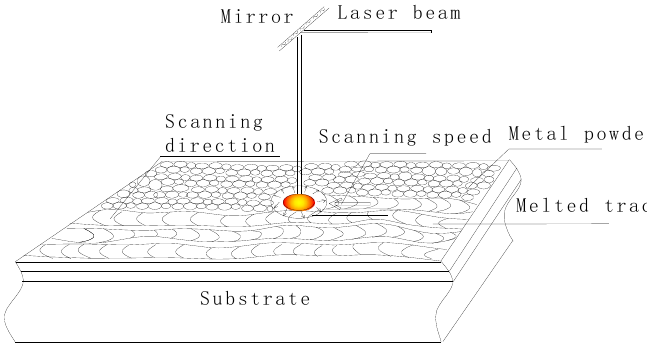
Figure 1. Diagram of equivalent dynamic heat source.